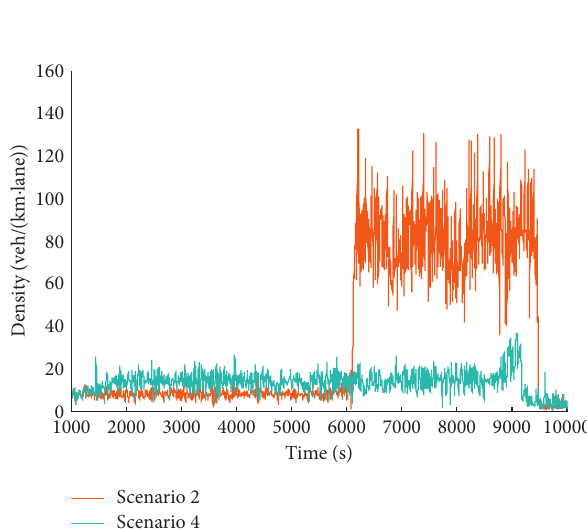
Figure 6: The sixth density comparison diagram between scenario 2 and scenario 4.